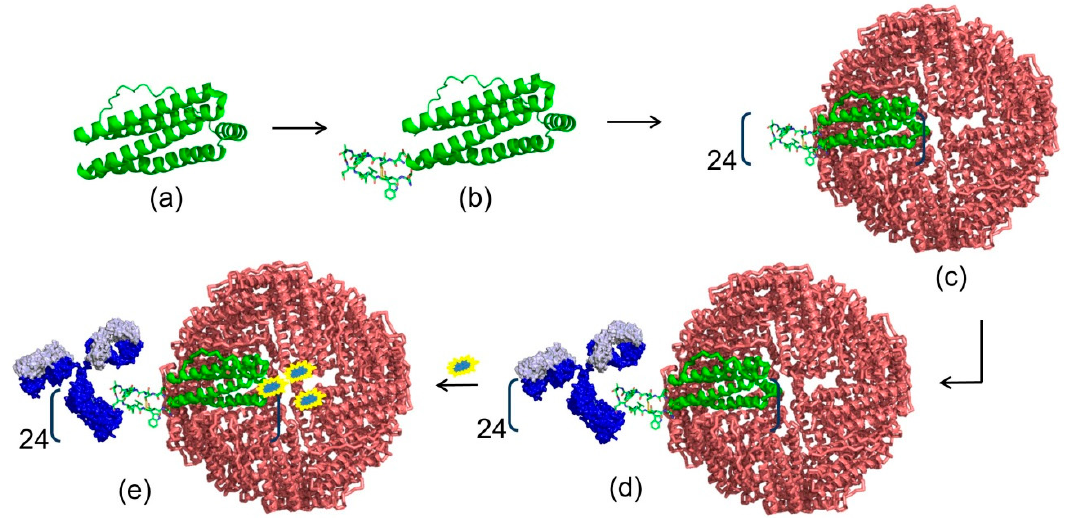
Figure 6. Illustration of the complexation of anti-Her2 antibody on a protein nanocage (ferritin) surface using the Fc-binding peptide Fc-III. ( a ) Ferritin monomer; ( b ) genetically engineered ferritin fusion monomer with Fc-III inserted in one of the loops; ( c ) self-assembled ferritin nanocage with 24 surface exposed Fc-III; ( d ) non-covalent binding of anti-Her2 antibody to the Fc-III functionalized protein nanocage; ( e ) covalent fluorescent labeling of the protein nanocage.